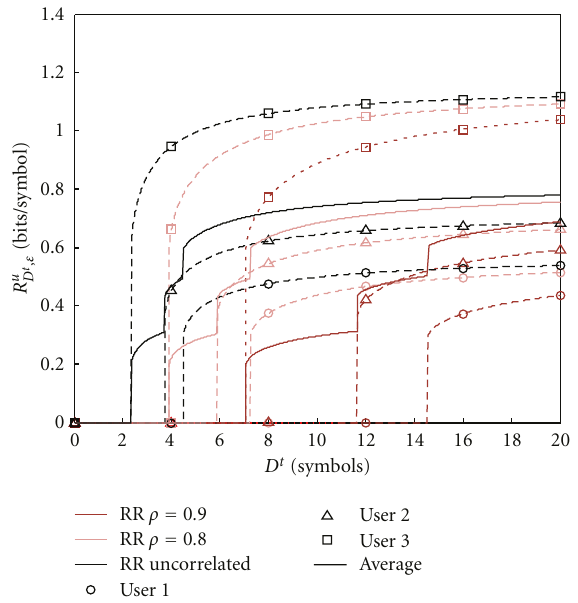
Figure 6: Achievable users’ rates with Round Robin scheduling in a time-correlated channel with exponential ACF of parameter ρ . = 5,7,12 dB, respectively. ε = 0 . 1. β Three users with γ u